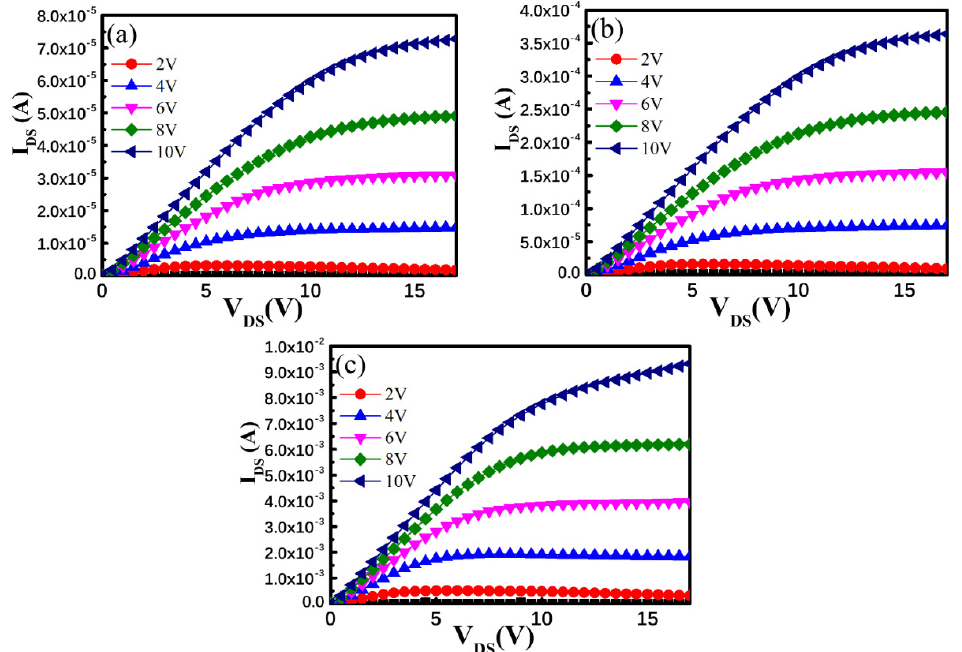
Figure 7. I DS –V DS output characteristics of a DG TFT annealed at ( a ) 100 °C, ( b ) 200 °C, and ( c ) 300